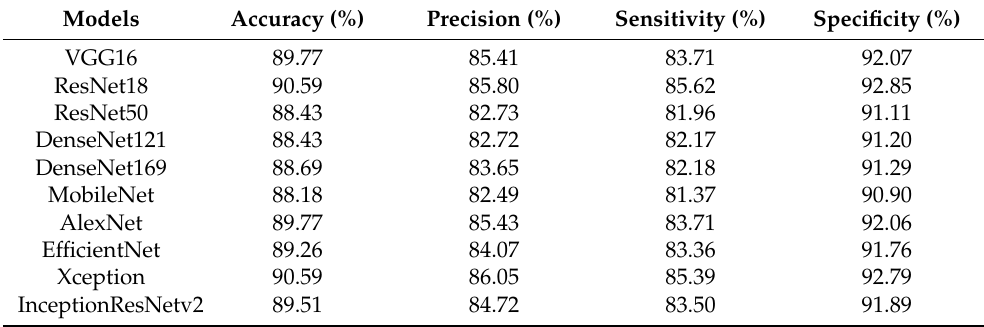
Table 8. Comparison of results on image classification without pre-training in the control group.